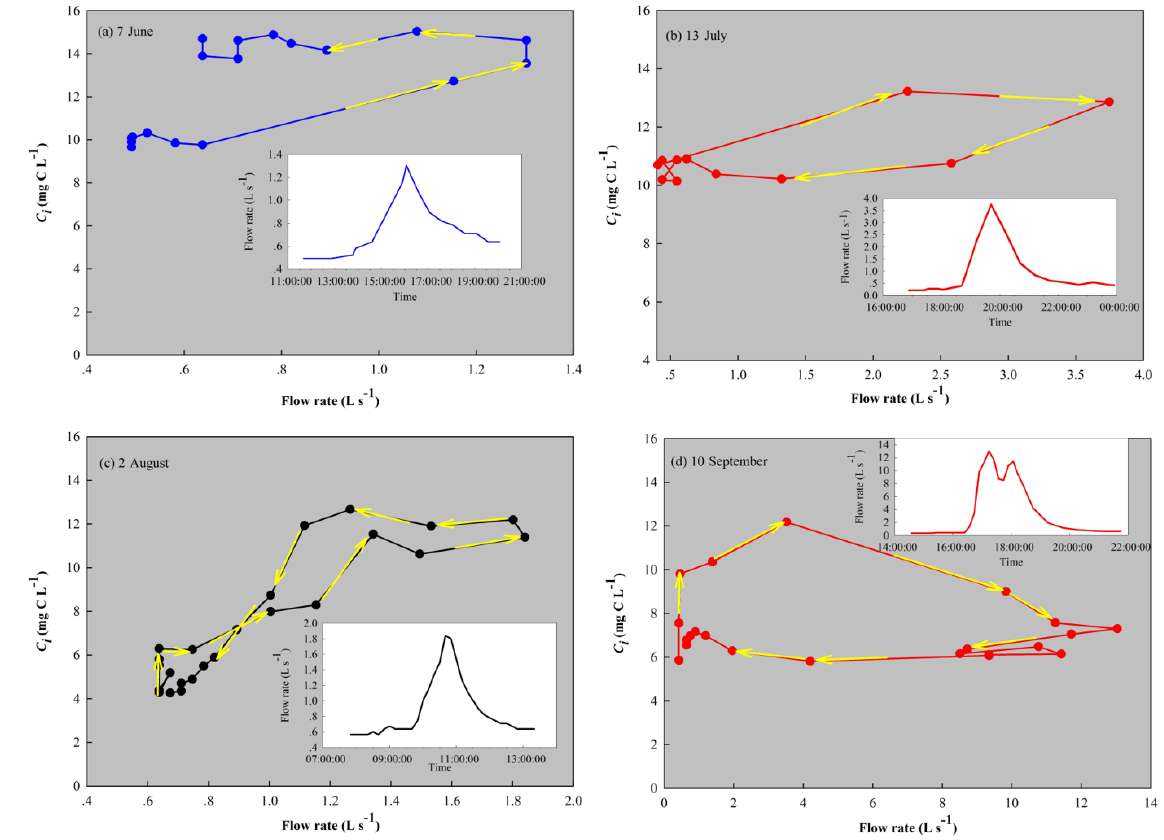
Figure 6. Hysteresis loops for four selected runoff events from June to September: (a) 7 June, (b) 13 July, (c) 2 August, (d) 10